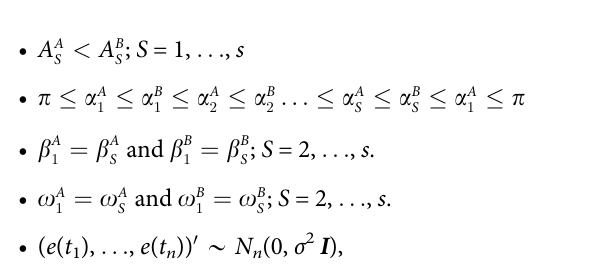
Fig 1. ( A ) FMM wave patterns for different parameter configurations. ( B ) Typical AP from an excitable neuron and corresponding fitted FMM model (left). Waves composing the FMM model (right).